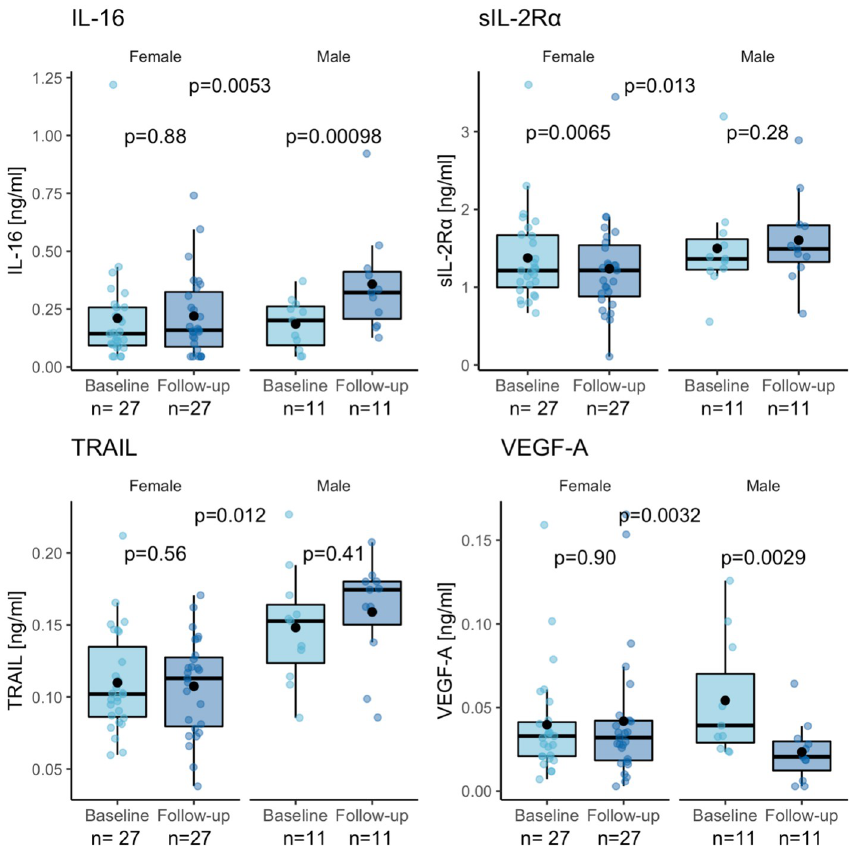
Fig 2. Sex-stratified analyses reveal differences in IL-16 and VEGF-A in males. Sex-stratified box plots of inflammatory biomarker levels before (baseline) and after (follow-up) the 12-week exercise intervention program. The differences in intervention response between sexes were evaluated with an ANCOVA model on analyte levels at follow- up adjusting for baseline analyte levels. The analytes with a difference in response between sexes at α = 0.05 are shown: IL-16 (p = 0.0053; partial eta 2 = 0.202), sIL-2R α (p = 0.013; partial eta 2 = 0.164), TRAIL (p = 0.012; partial eta 2 = 0.166), VEGF-A (p = 0.0032; partial eta 2 = 0.223). The post-hoc pre-post differences in analyte levels for each sex were assessed using Wilcoxon tests (significance set at α = 0.004) and are presented under the corresponding sex. Abbreviations: IL-16 = Interleukin-16, sIL-2R α = soluble Interleukin-2 receptor subunit alpha, TRAIL = Tumor necrosis factor-related apoptosis-inducing ligand, VEGF-A = Vascular endothelial growth factor A.